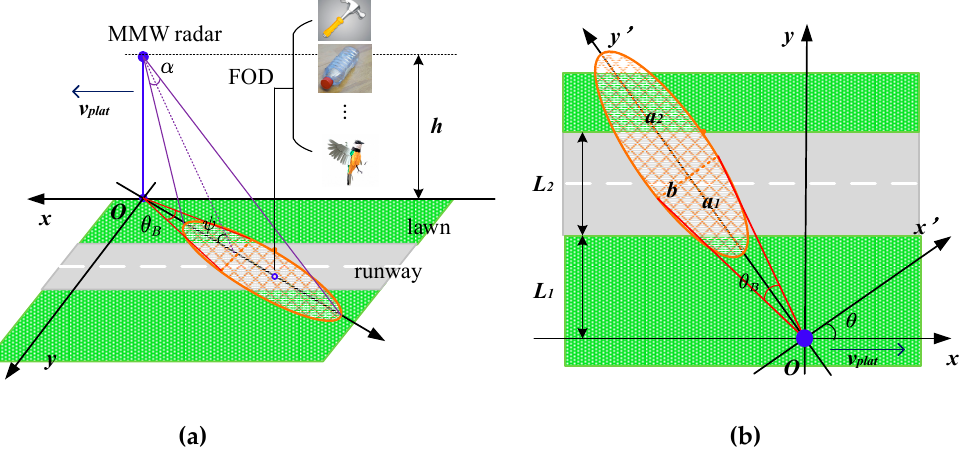
Figure 1. ( a ) Geometrical model of foreign object debris (FOD) detection; ( b ) The vertical view of (a).